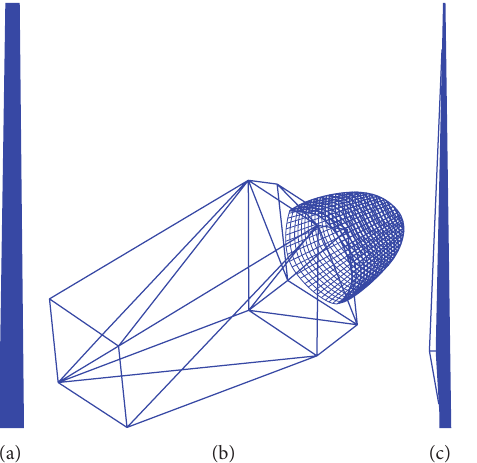
Figure 2: (a) Facets-based design of the mast. (b) Facets-based design of the nacelle. (c) Facets-based design of the blade.